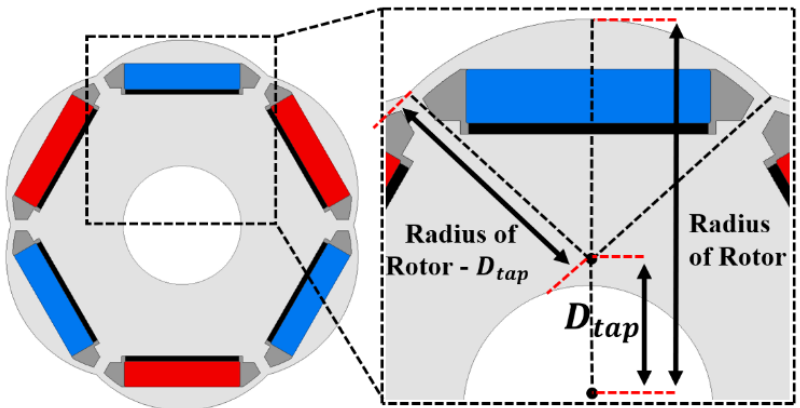
Figure 14. Variable D tap for tapering the rotor.